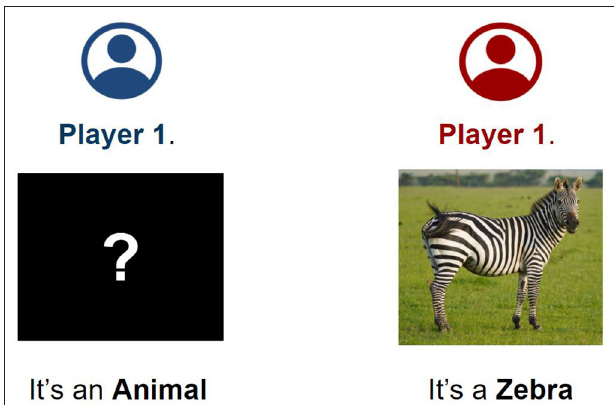
FIGURE 2 | The setup step of the gamified activity. Player 1 is provided with the category of the entity they have to guess (in this case, they have to guess an animal). Player 2 is supplied with a picture of the entity and its name (in this case, they are provided with the picture of a